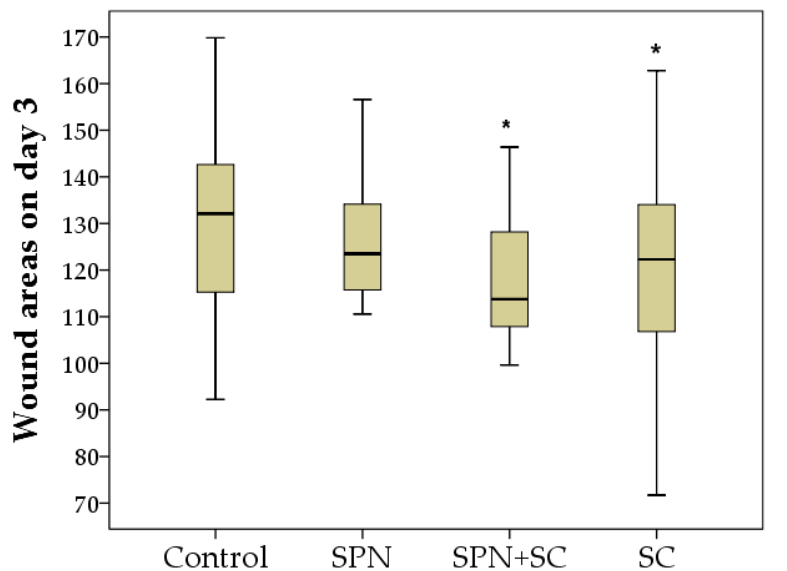
Figure 3. Wound areas on day 3 of the study in different groups (mm 2 ). Notes: *—difference from the control group at p < 0.05. Post hoc analysis score (Dunnett’s t -test for comparison with a control group). Data are presented as median and interquartile range.